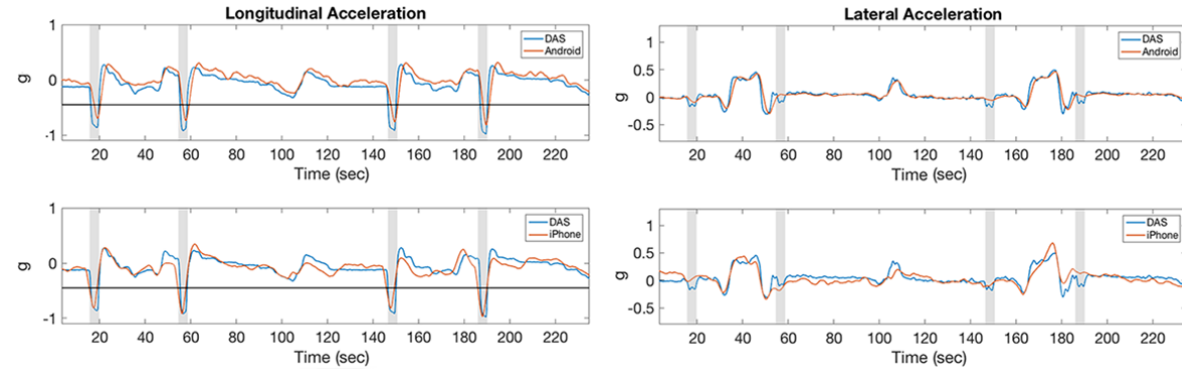
Figure 9. Acceleration measurements for hard braking maneuvers. The horizontal line along longitudinal acceleration represents the threshold of -0.45 g. Shaded stripes identify the approximate time of the braking maneuvers. DAS: data acquisition system.